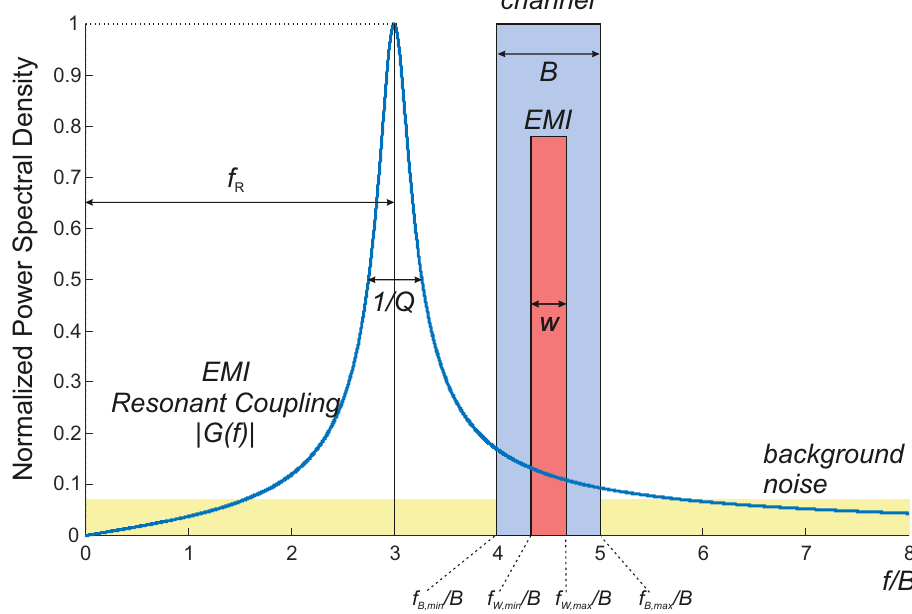
Figure 3. EMI resonant coupling in the frequency domain: power spectral densities of nominal signals, EMI, background noise and resonant coupling transfer